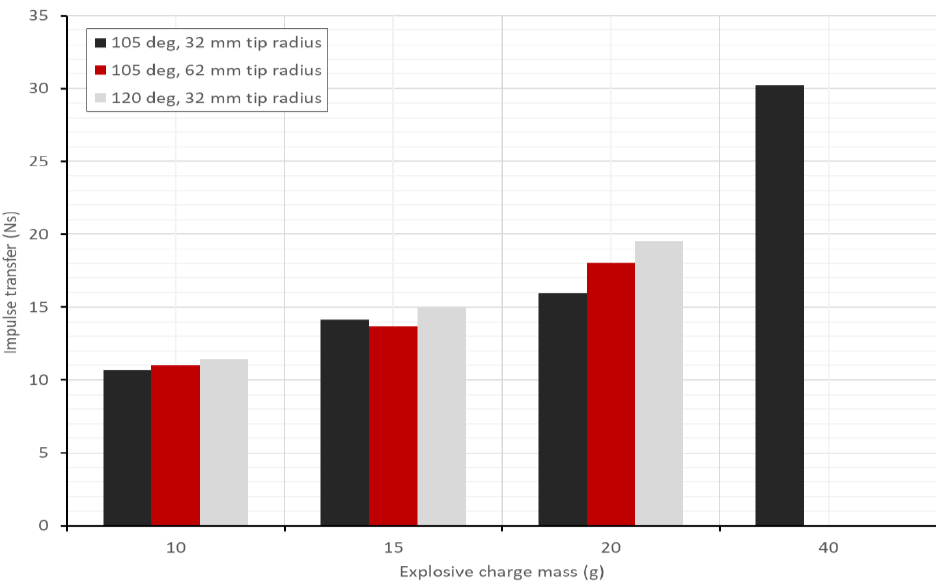
Figure 11. Graph of impulse transfer versus charge mass obtained from the blast test data.